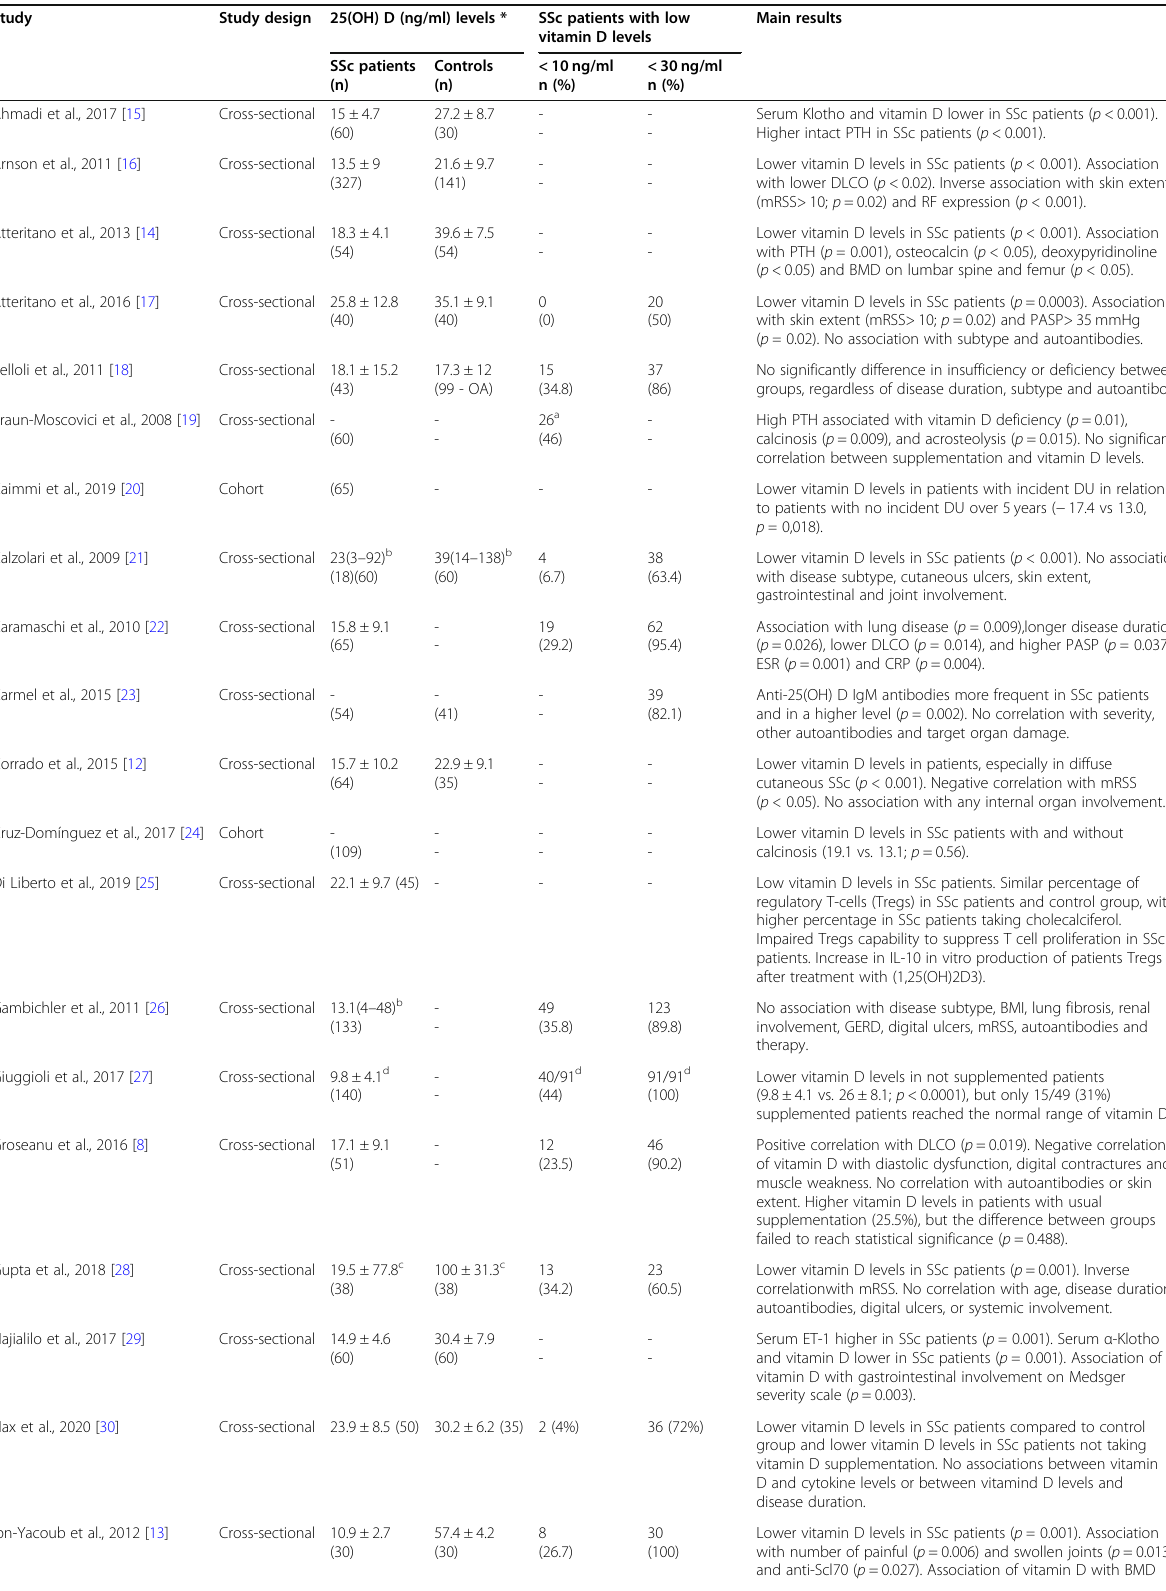
Table 1 Characteristics and results of the selected